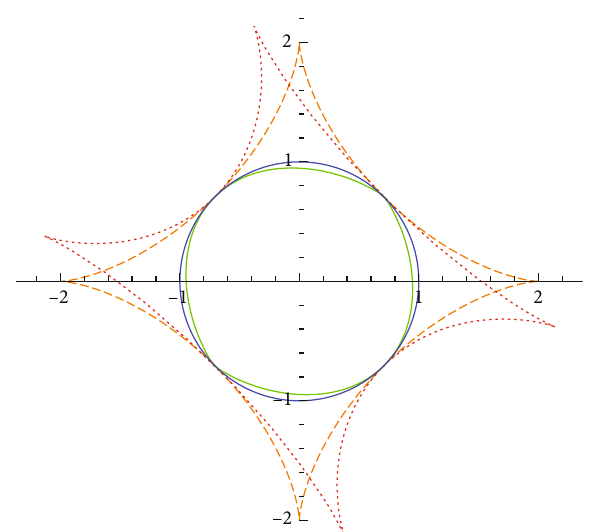
Figure 2: The mixed-type curve (blue) and the evolutoid (evolute) of